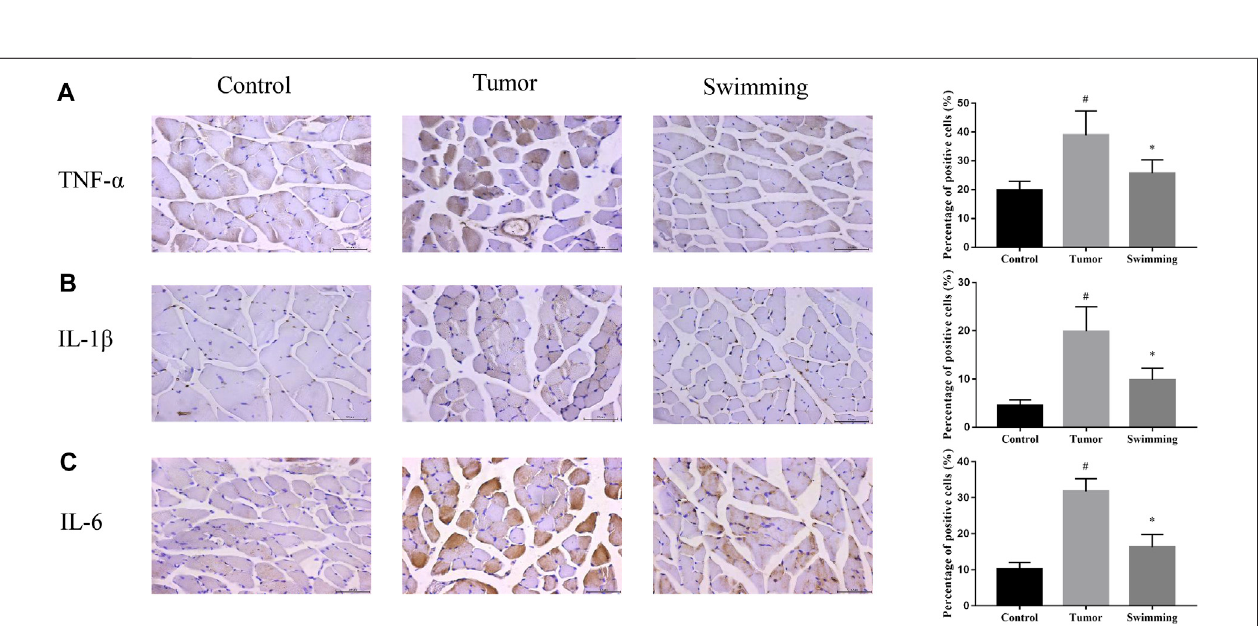
Frontiers in Molecular Biosciences |